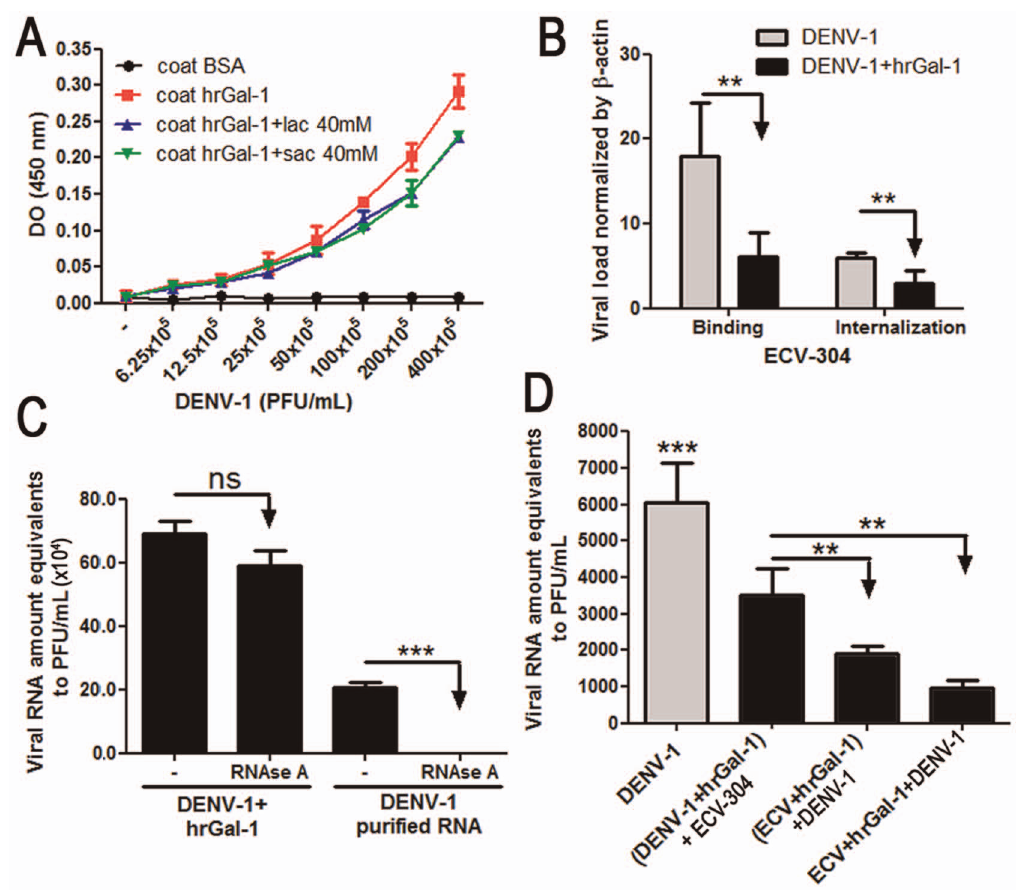
Figure 4. Gal-1 acts at early stages during DENV-1 infection. (A) Binding of DENV-1 to hrGal-1 in a dose-dependent manner. Serial two-fold dilutions of DENV-1 were applied to 96-well plates coated with 1 m g of hrGal-1 per well, and the bound virus particles were detected by ELISA with mouse anti-E protein antibody. BSA-coated wells served as the negative control. To assess the involvement of Gal-1 CRD, the assay was performed in presence of 40 mM lactose or sucrose. Each value represents the mean 6 the SD from 4 assays performed in duplicates. (B) Adsorption and internalization assays: for adsorption assay, ECV-304 cells were infected with DENV-1 at MOI of 10 in presence or absence of 10 m M hrGal-1 during 1 h at 4 u C and then washed to remove viral inoculum. Cells were collected and the viral RNA was quantified by Real-Time PCR. Data was normalized by host b -actin expression. For internalization assay, ECV-304 cells were inoculated with DENV-1 (MOI of 10) at 4 u C for 1 hour. Then, cells were washed and transferred to 37 u C and hrGal-1 (10 m M) or only medium were added to culture. After 1 hour of incubation, non-internalized viruses were inactivated with citrate buffer and viral loads were quantified by Real-Time PCR. Data is presented as Viral RNA amount equivalents to PFU/mL 6 SD from 3 experiments assessed in triplicates. (C) For virucidal assay, DENV-1 was incubated with hrGal-1, in the presence or absence of RNAse. After 1 h incubation at 37 u C, RNA was isolated and subjected to RT-Real-Time PCR. Purified viral RNA incubated or not with RNAse was used as control (N=3). (D) ECV-304 cells were infected with DENV-1 at a MOI of 0.5 (DENV-1). For the treatments, hrGal-1 was incubated with ECV-304 and DENV-1 simultaneously (ECV + Gal-1 + DENV), or hrGal-1 (10 m M) was pre-incubated with either ECV-304 cells or with DENV-1 (MOI 0.5) for 60 minutes before the inoculation (ECV + hrGal-1) + DENV versus (DENV + hrGal-1) + ECV, respectively. At 72 hours postinfection, supernatants were collected and the viral loads were quantified by Real-Time PCR (N=3). **p , 0.001; ***p , 0.0001.